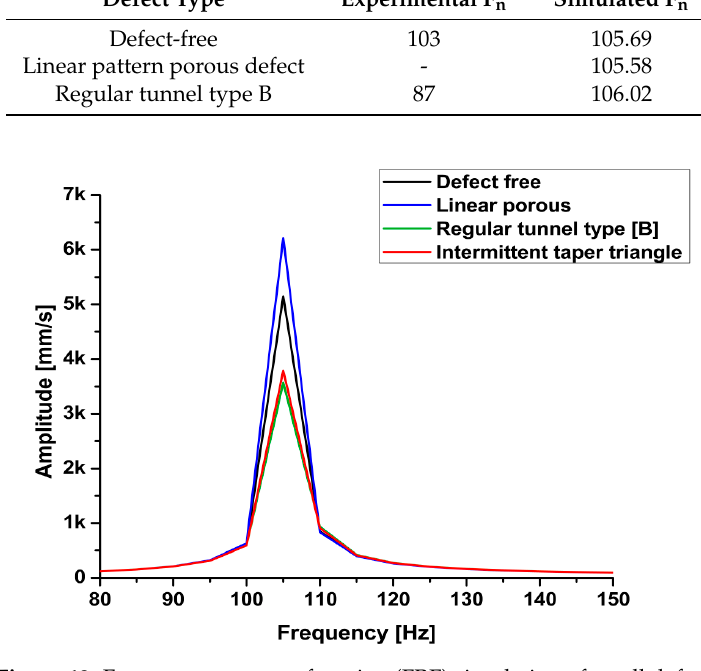
Figure 13. Frequency response function (FRF) simulation of small defects.